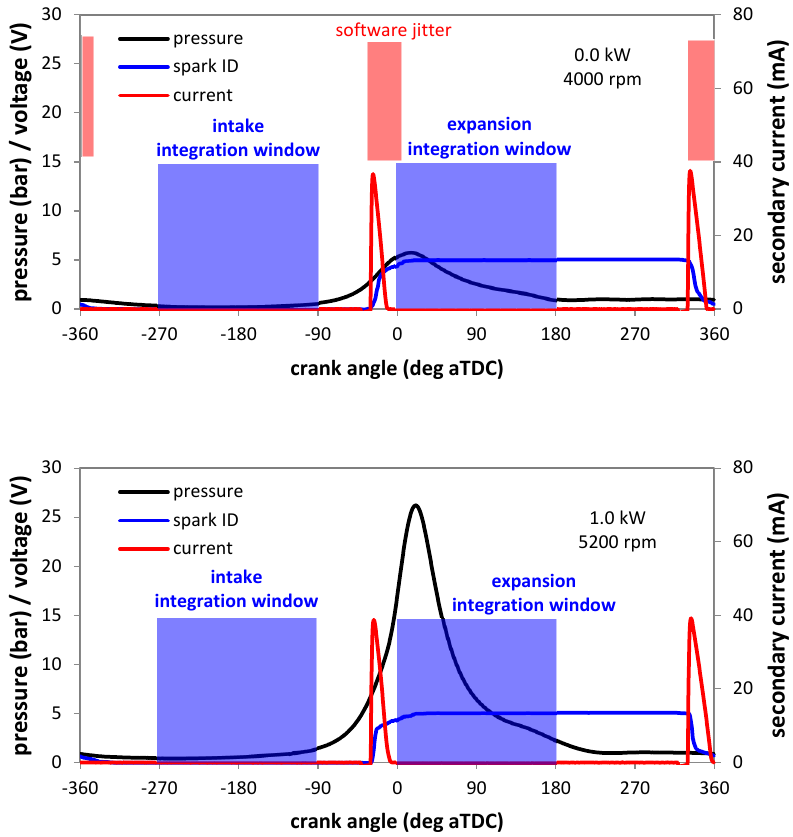
Figure 3. In–cylinder pressure, spark ID signal, and secondary current averaged over 200 consecutive cycles for idle ( top ) and full load ( bottom ) conditions.